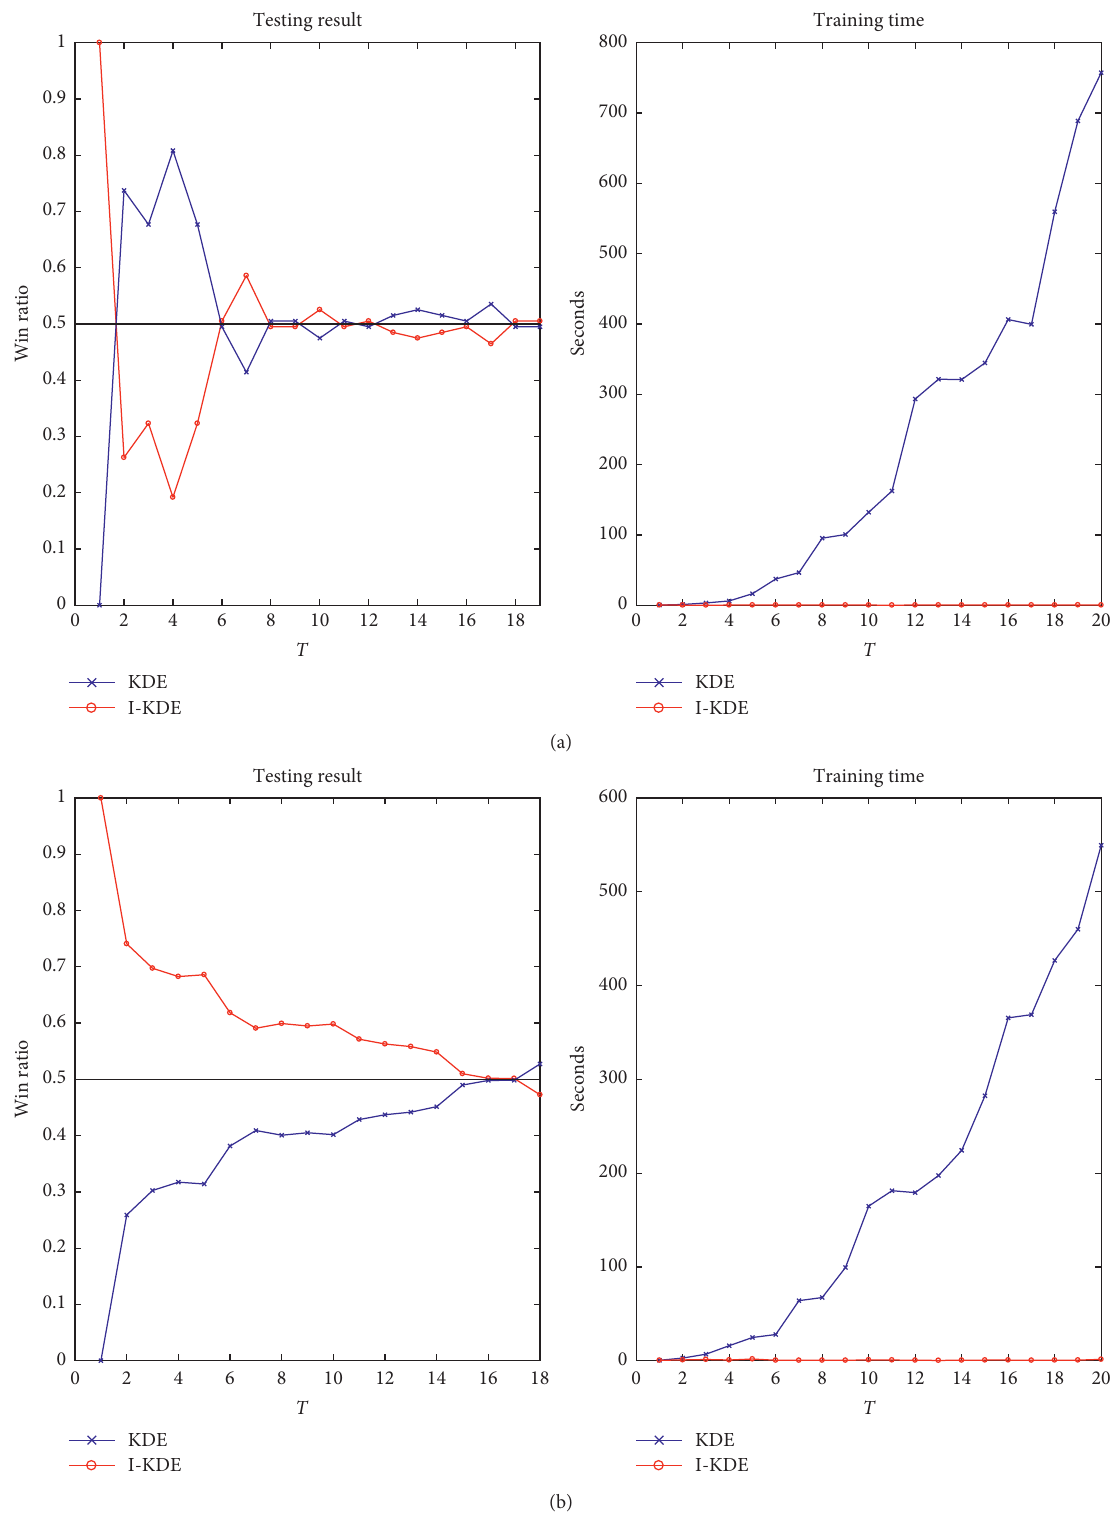
Figure 5: The convergence of the I-KDE on beta and 2-dimensional trimodal normal distributions. (a) Univariate case on beta distribution (99 testing samples are selected from 0.01 to 0.99 with incremental step of 0.01). (b) Multivariate case on 2-dimensional trimodal normal distribution (40000 testing samples are selected with the incremental steps of (0.01, 0.01) in the space of [ − 9.9, 10] ∪ [ − 9.9,